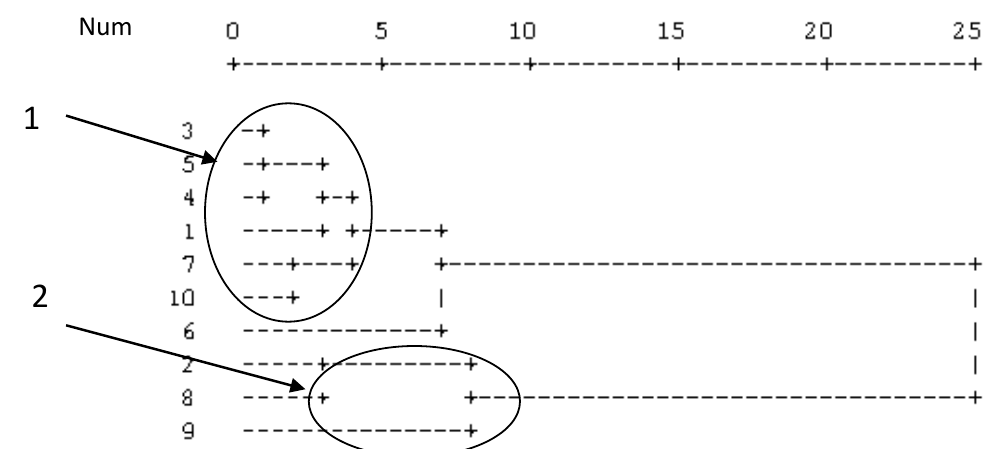
Fig.1. Dendogram of cluster analysis of students’ distribution into groups by heart beats rate (HBR) values in situation of fear of heights’ overcoming and by psycho-physiological indicators: Num (by vertical axis) -= conventional number of the tested; Horizontal upper scale – standardized “scale of distances” between testing indicators of the tested; 1, 2 – groups of the tested, formed as a result of cluster analysis.